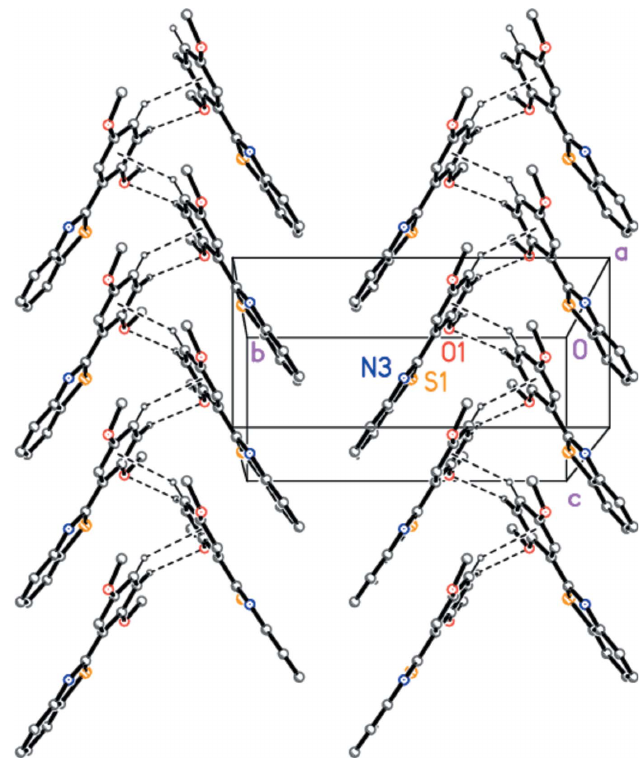
Figure 2 Crystal packing of 3 , viewed perpendicular to (100) in the region x ’ 0.25. Dashed lines indicate ‘weak’ C—H (cid:3)(cid:3)(cid:3) O hydrogen bonds or C—H (cid:3)(cid:3)(cid:3) (cid:2) contacts. Atom labels correspond to the asymmetric unit.